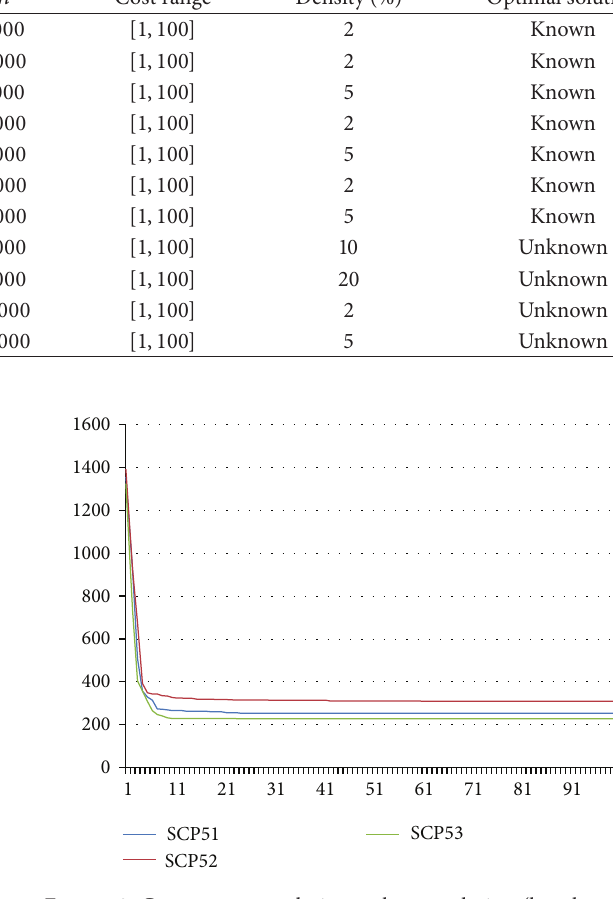
Figure 3: Convergence analysis to a better solution (benchmarks: SCP51, SCP52, and